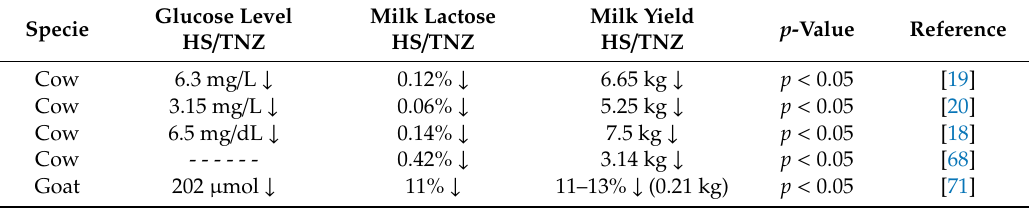
Table 1. The e ff ect of heat stress on the blood glucose, milk lactose, and milk yield in dairy animals.